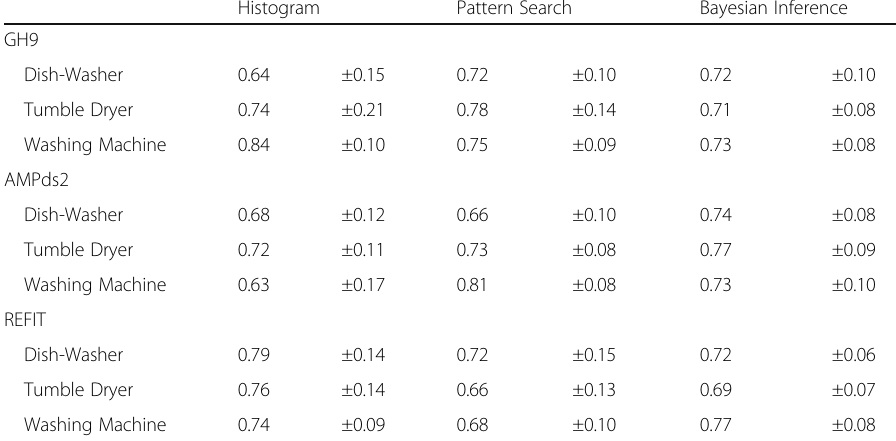
Table 1 Area Under Curve for predicting 1 week based on the preceding 8 weeks. The results are averaged over 2 years (90 samples) with corresponding standard deviation Histogram Pattern Search Bayesian